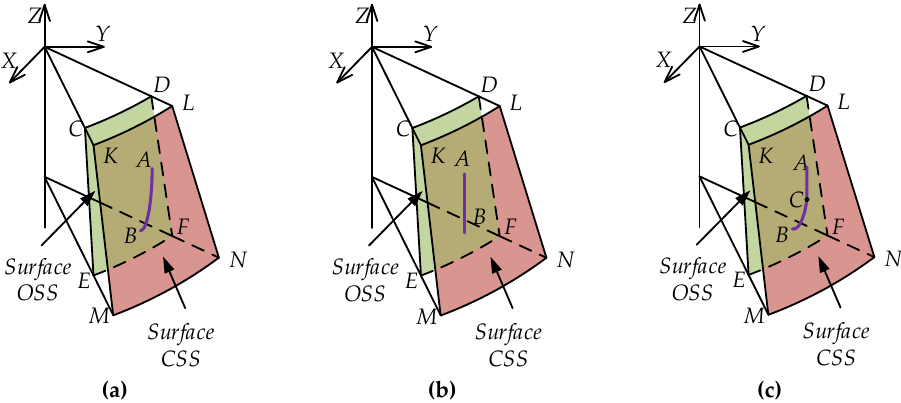
Figure 4. The motion characteristics of particles. ( a ) The spatial sliding. ( b ) The free-falling. ( c ) The spatial compound falling.